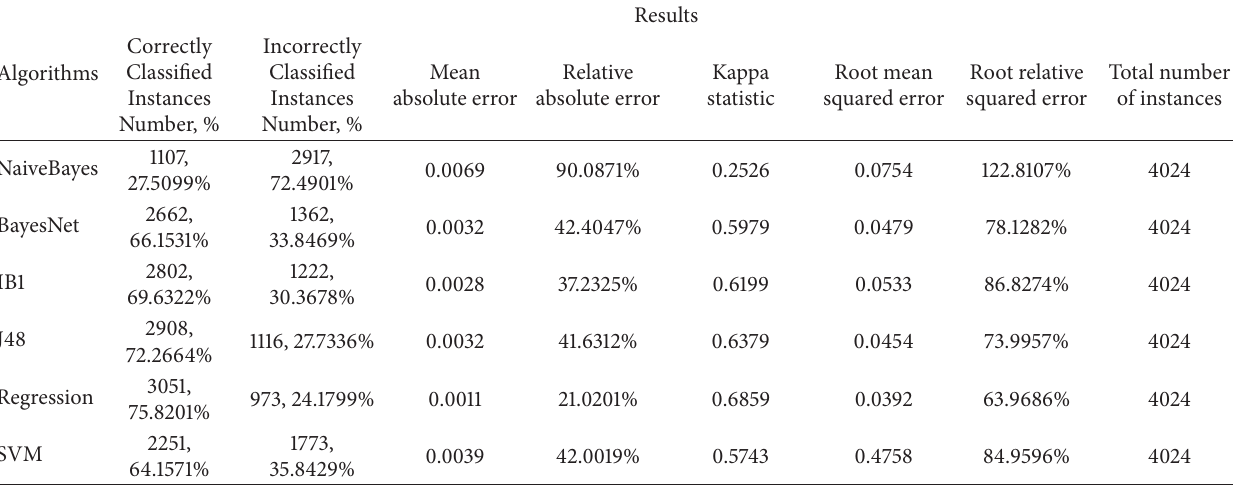
Table 1: The statistical analysis of data set 1 for specified classification methods.